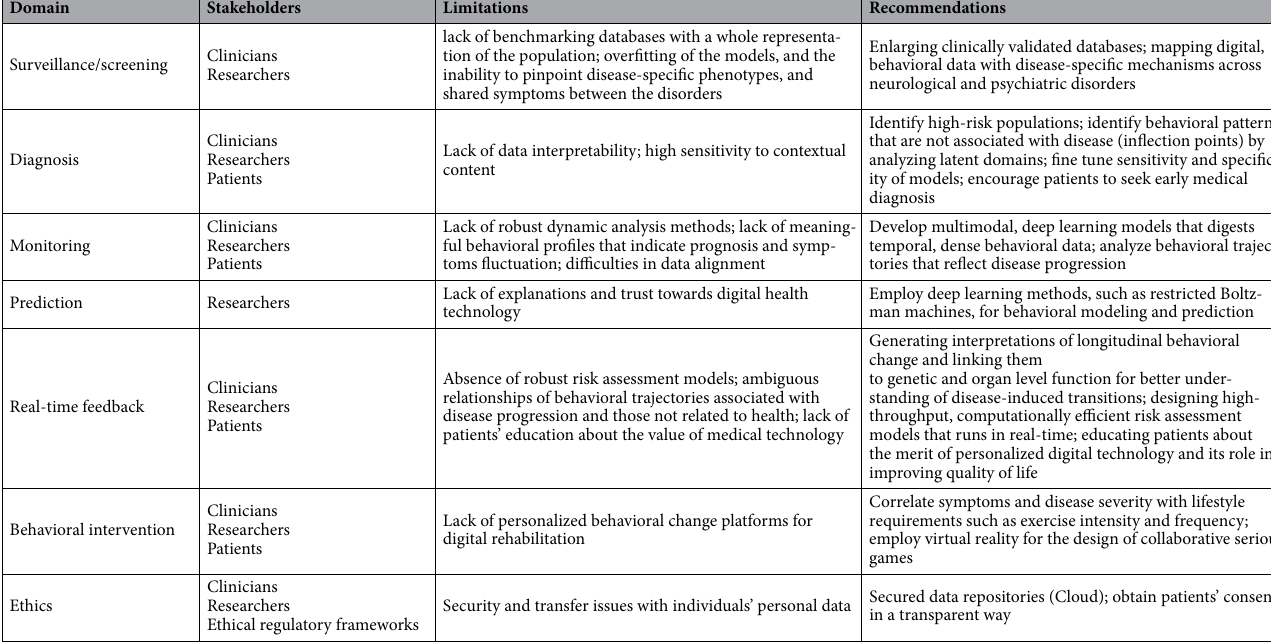
Table 2. Future directions for the digital biomarkers research based on the “co-creation